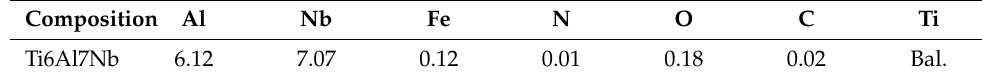
Table 5. Chemical composition of Ti6Al7Nb substrates.